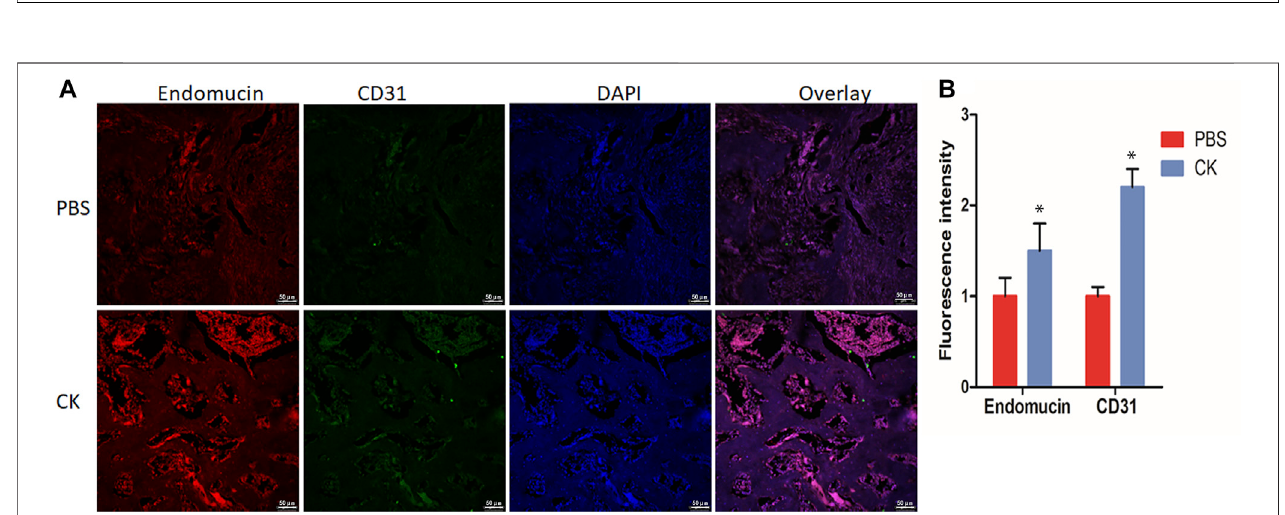
FIGURE 5 | CK regulated H-type vessel formation in fracture callus. (A) Representative immuno fl uorescence double staining and (B) Quanti fi cation of CD31 (green), EMCN (red) of fracture calluses in PBS and CK groups, Scale bars = 50 μ m, * p < 0.05, compared with the PBS group, n = 3.